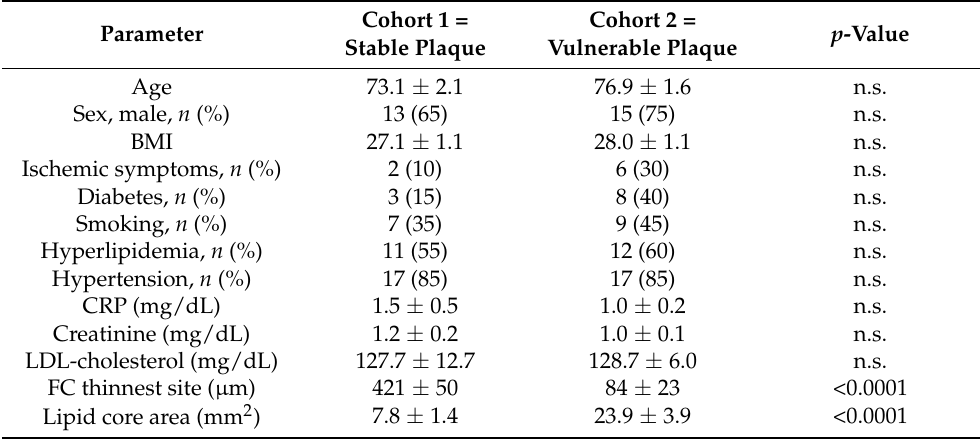
Table 1. Clinical data of the enrolled patient